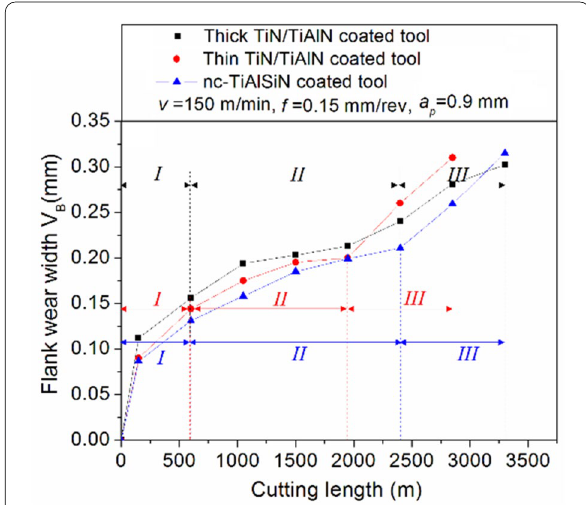
Figure 7 Flank wear width versus cutting length for the three coated tools in dry turning of